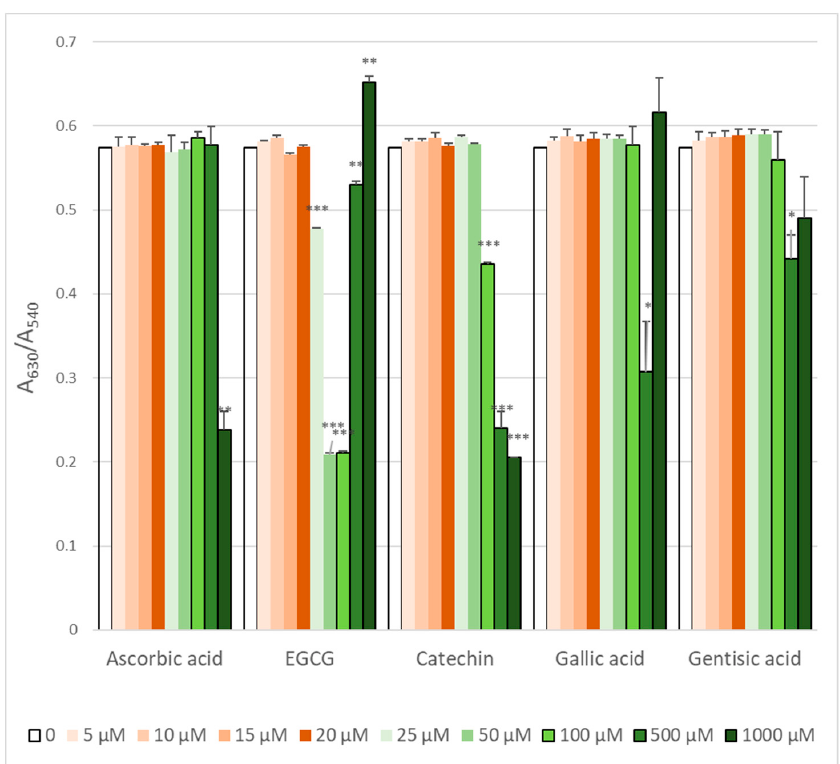
Figure 4. Prevention of AAPH-induced hemoglobin oxidation by selected antioxidants. * p < 0.05, ** p < 0.01, *** p < 0.001 with respect to control.